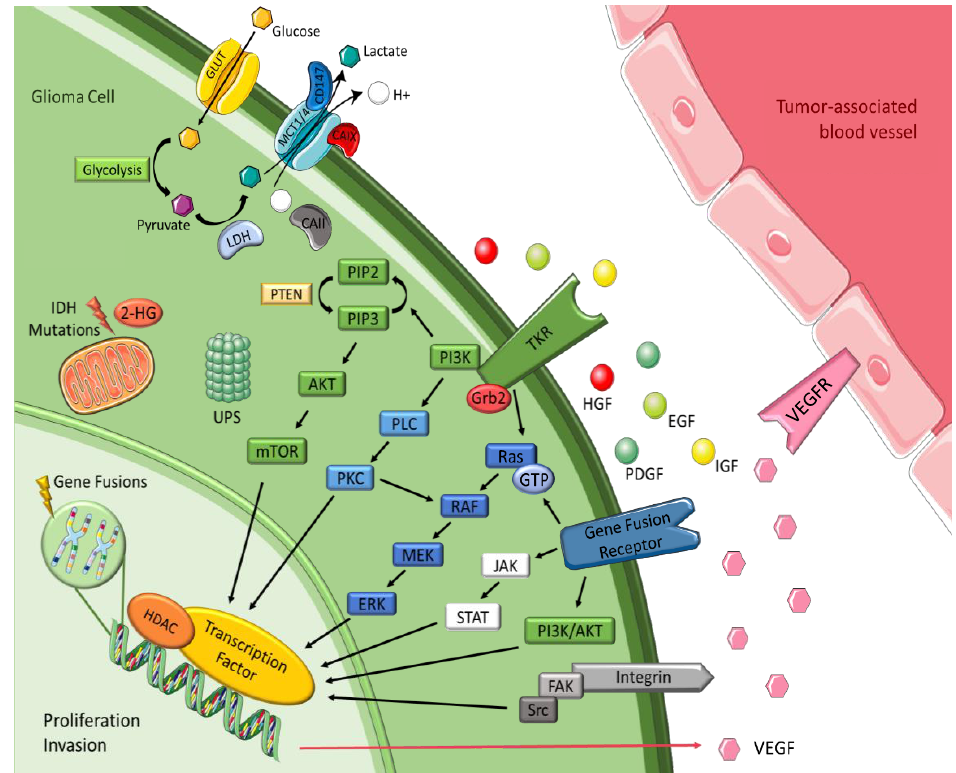
Figure 2. Malignant glioma signaling pathways. Figure drawn with